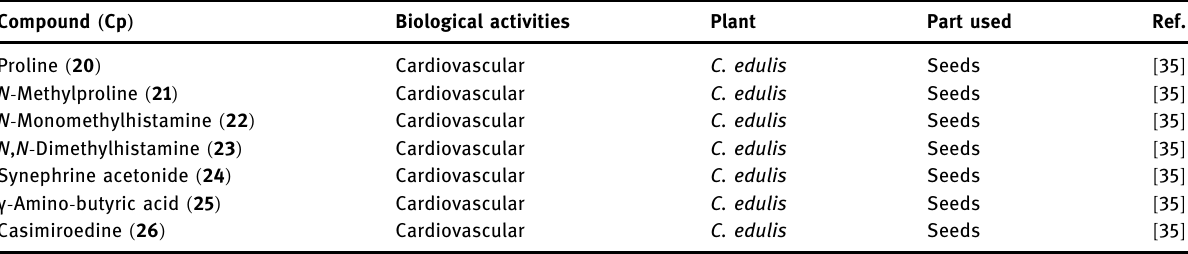
Table 6: Pharmacological properties of compounds isolated from Casimiroa species Compound ( Cp